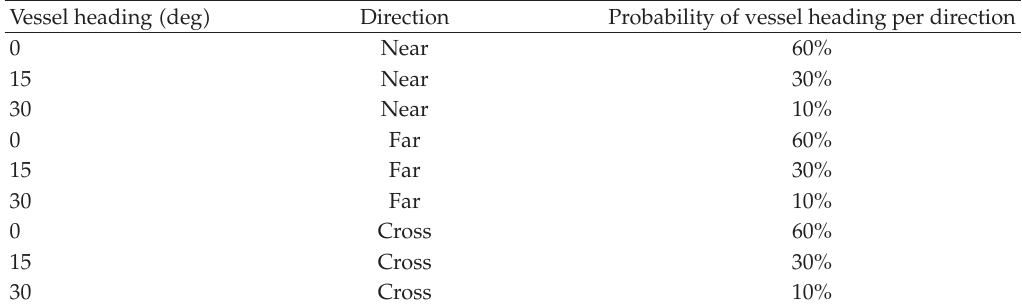
Figure 12: Umbilical operated from a turret-moored FPSO. Table 3: Fatigue load case